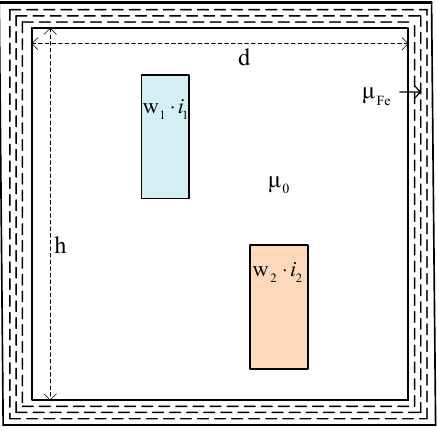
Figure 4. 2D problem for a transformer window with two arbitrarily located windings.